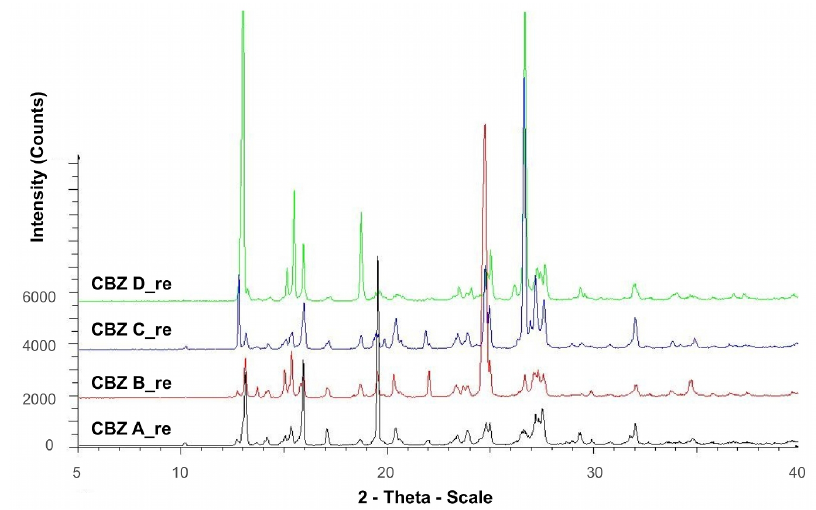
Figure 1. X-ray powder diffraction of recrystallized CBZ